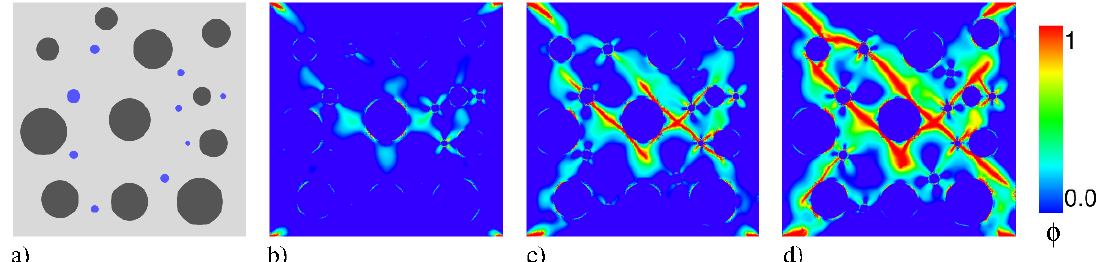
Figure 8. Concrete failure in poro-elasto-plastic media. ( a ) Schematic of the concrete idealized microstructure: Light gray color refers to the hydrated cement paste, dark gray color stands for the unhydrated clinker particles, and blue color depicts the water content. ( b – d ) Evolution of crack phase-field φ for different deformation states up to final failure, as outlined in